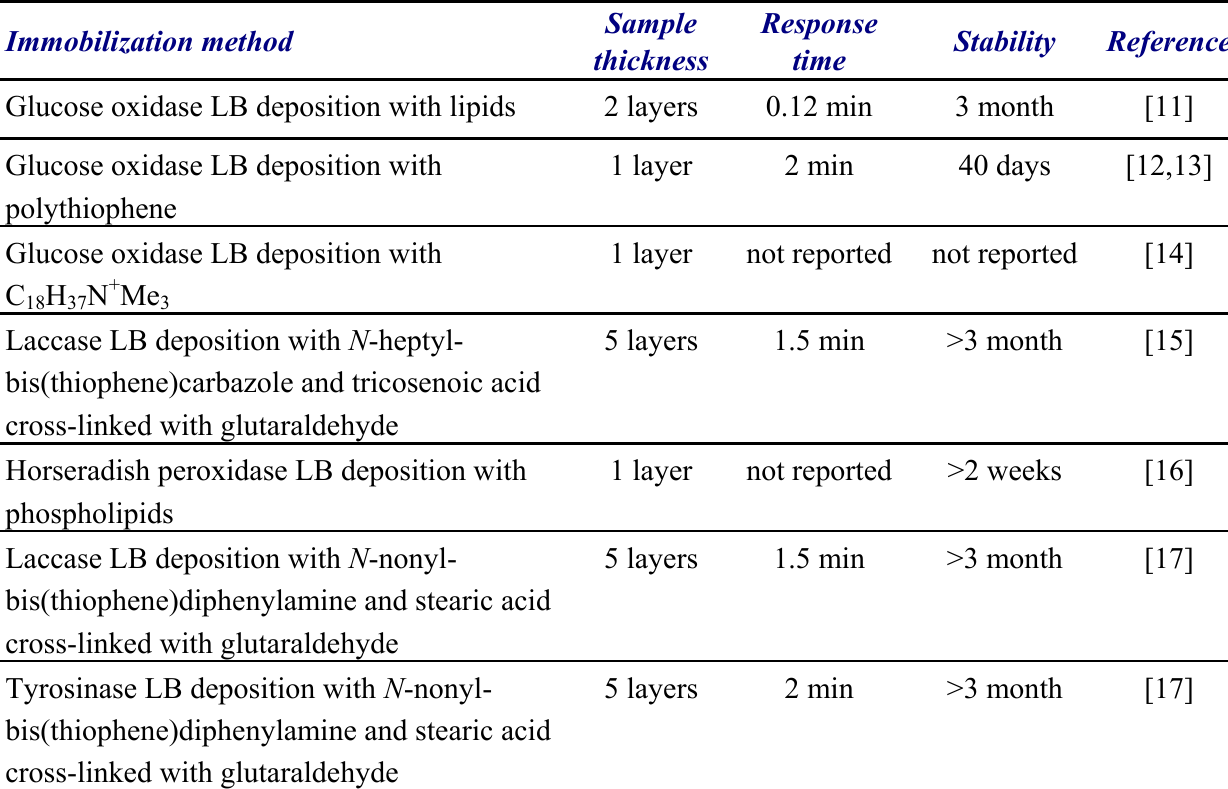
Table 1. Comparison of selected protein sensors immobilized in thin